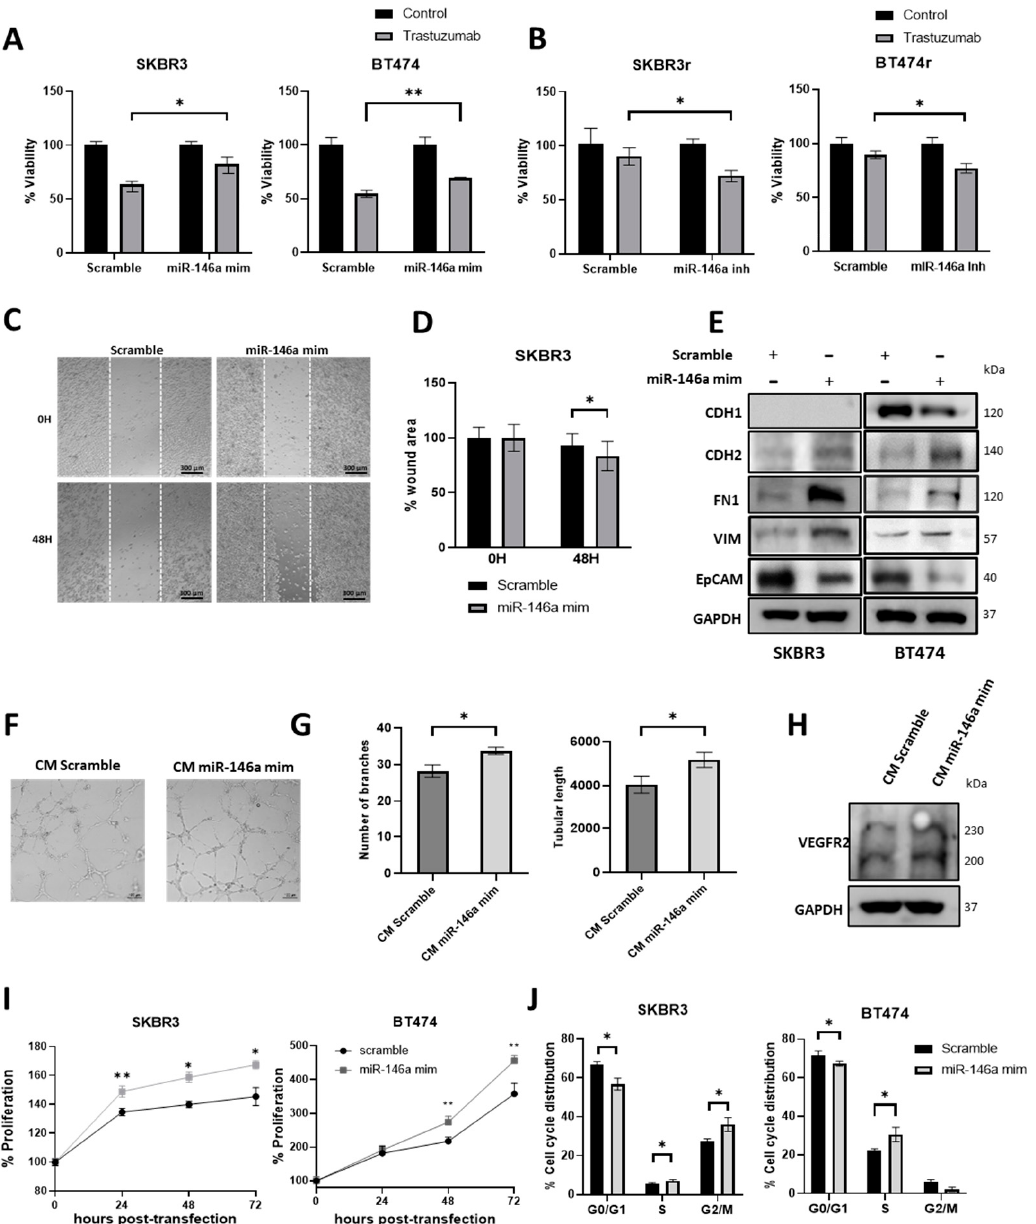
Figure 3. Analysis of miR-146a-5p e ff ect in response to trastuzumab, migration, angiogenesis, proliferation, and cell cycle . ( A ) Viability analysis of SKBR3 and BT474 transfected with 50nM miR-146a-5p mimic ( B ) SKBR3r and BT474r transfected with 50 mM miR-146a-5p inhibitor ( B ) with or without treatment with 15 µg/mL of trastuzumab for 7 days. ( C ) Representative images of wound-healing cell migration assay of SKBR3 transfected with 50 nM miR-146a-5p mimic. Magni fi cation: 10×. Scale bar: 300 µm. ( D ) Quanti fi cation of the remaining wound area at 0 and 48 h under conditions indicated above. ( E ) Expression of epithelial-to-mesenchymal transition markers (CDH1, CDH2, FN1, and VIM) and EpCAM in SKBR3 and BT474 via Western blot after 50 nM miR-146a-5p mimic transfection. GAPDH was used as loading control. ( F ) Representative images of in vitro angiogenesis assay of HUVEC-2 cells (10× magni fi cation). ( G ) Representations of the number of branching points and the relative tubular length 8 h after addition of CM of SKBR3 transfected with miR-146a-5p or scramble control. ( H ) Expression of VEGFR2 in HUVEC-2 after 24 h of treatment with CM of SKBR3 transfected with miR-146a-5p mimic or scramble control. ( I ) Proliferation analysis of SKBR3 and BT474 transfected with 50 nM miR-146a-5p mimic or scramble at 0, 24, 48, and 72 h. ( J ) Cell cycle distribution of SKBR3 and BT474 cells overexpressing miR-146a-5p. Propidium iodide was used for staining, and the analysis was performed via fl ow cytometry. Each experiment was performed in technical and biological triplicate. * p -value < 0.05; ** p -value < 0.01. CM: Conditioned medium; CDH1: E-Cadherin; CDH2: N-cadherin; FN1; Fibronectin; VIM: Vimentin; EpCAM: Epithelial cell adhesion molecule. The uncropped blots are shown in Figure S5.